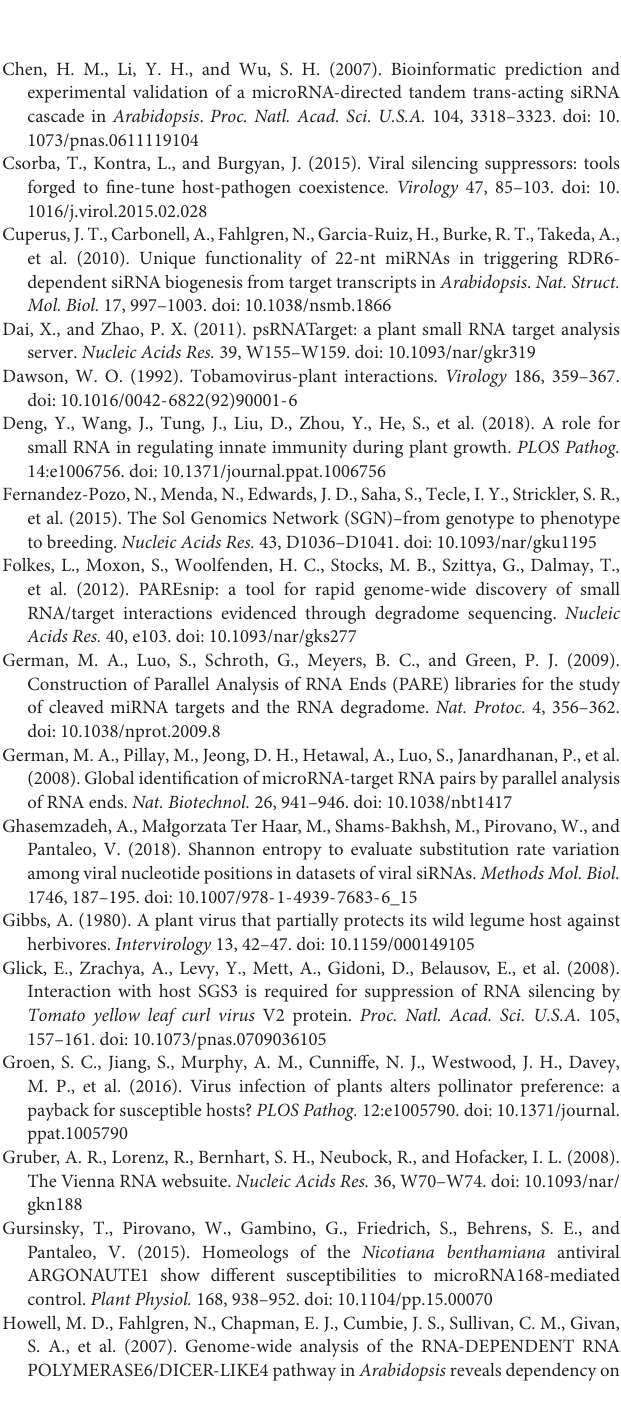
TABLE S4 | Output of PAREsnp listing 5 (cid:48) RNA remnants of cDNA targeted by 21-nt-long secondary siRNAs in tomato TYLCSV-infected plant tissues. TABLE S5 | Output of PAREsnp listing 5 (cid:48) RNA remnants of cDNA targeted by 22-nt-long secondary siRNAs in tomato TYLCSV-infected plant tissues. TABLE S6 | Oligonucleotides used for quantitative reverse transcription PCR experiments of selected transcripts in TYLCSV-infected vs. mock-inoculated